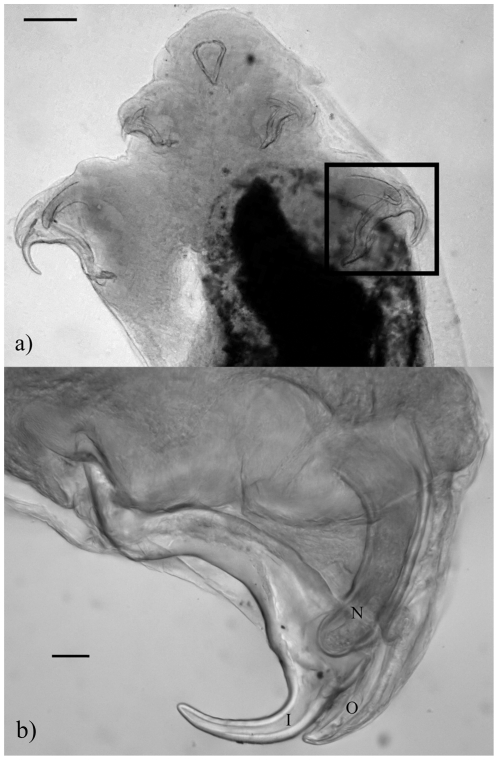
Molting Raillietiella frenatus that has retained the hooks of two previous instars.(a) Anterior view of molting R. frenatus from Hemidactylus frenatus, scale bar is 0.1 mm. (b) Close-up of posterior hooks from the same individual showing retained posterior hooks from two previous instars. The oldest hook is marked O, the intermediate aged hook is marked I, the newest hook is marked N. Photograph is compiled from five focus-stacked images of the same field of view, scale bar is 20 µm.